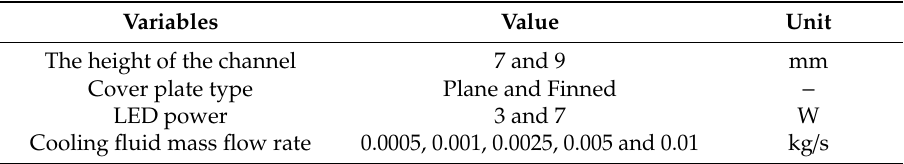
Table 4. The variables considered in the numerical analysis for the liquid cooling